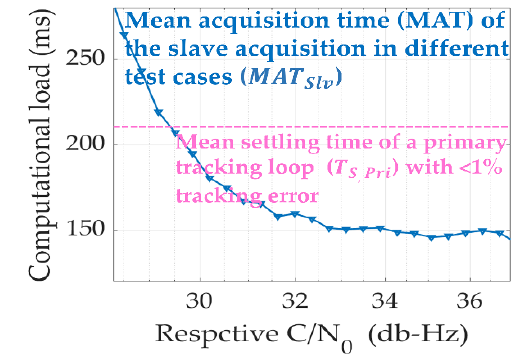
MAT and T with different slv and T S , pri with different C / N 0 slv , S pri